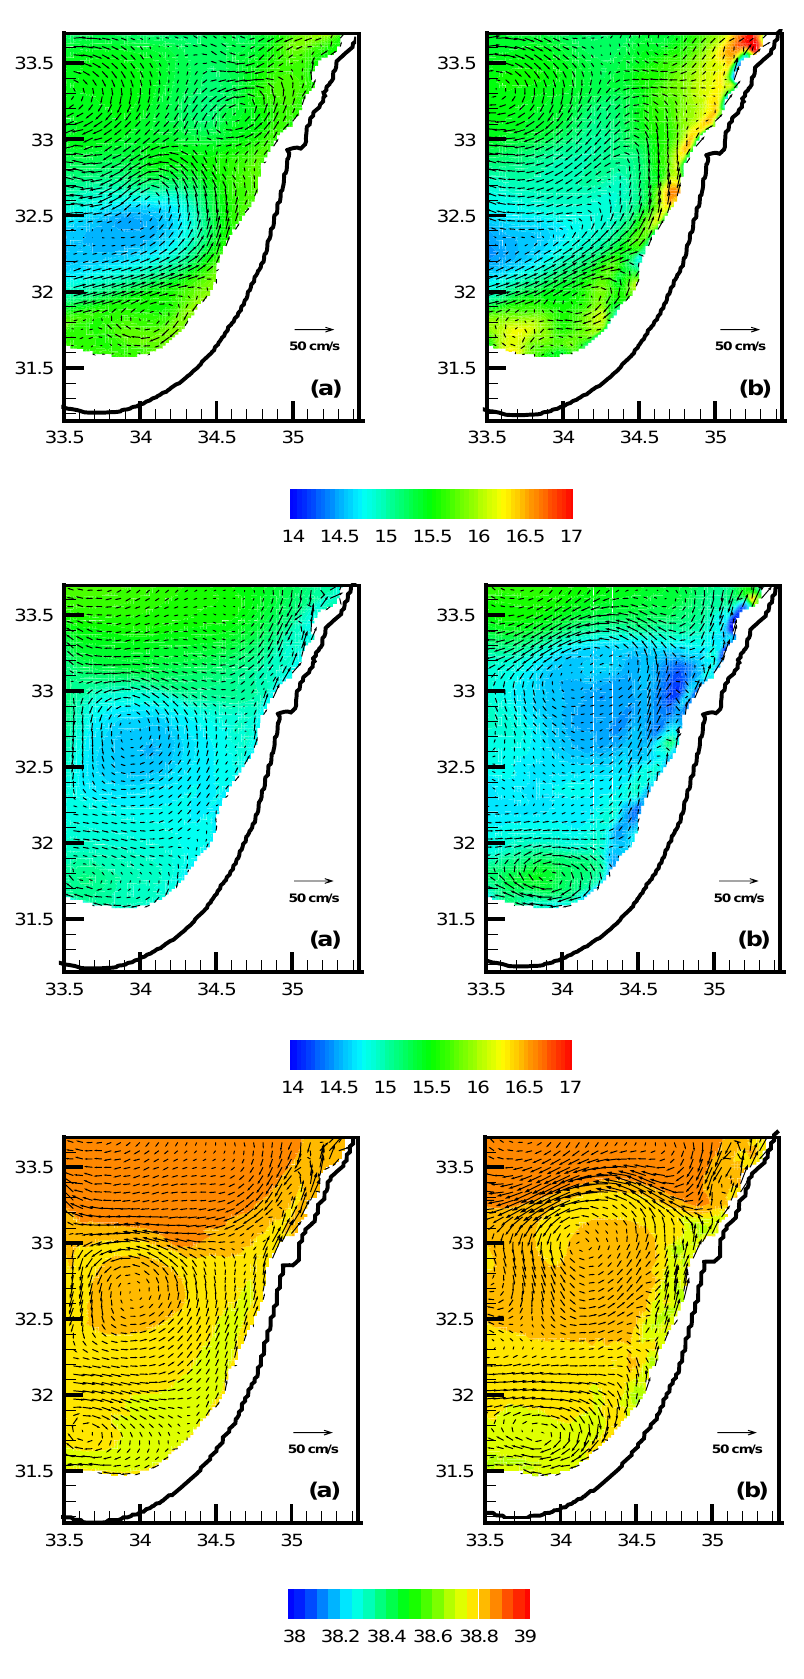
Fig. 12. Simulated salinity and veloc- ity at 100m: (a) 10-day average for 10– 20 August of the third year, and (b) 10- day average for 10–20 August from the intermediate